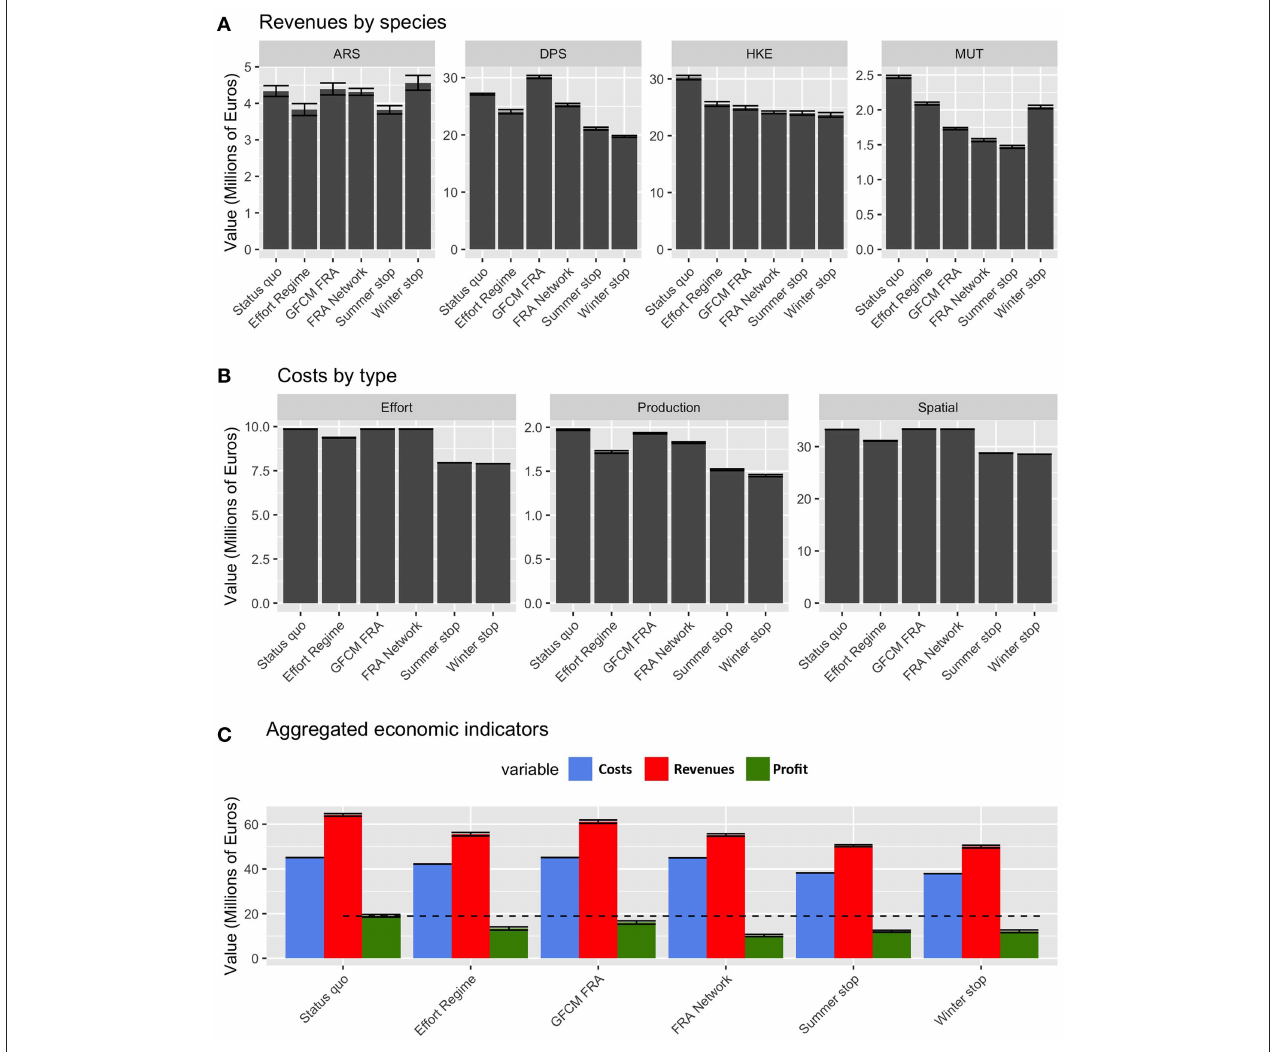
FIGURE 9 | Barplot (mean and MSE) representing (A) the values of landings for each species and scenario, corresponding to the new fishing effort pattern after the introduction of the different management measures; (B) the corresponding costs by type and scenarios; (C) the aggregated costs, revenues, and corresponding profit by scenario, for the whole fleet of Italian